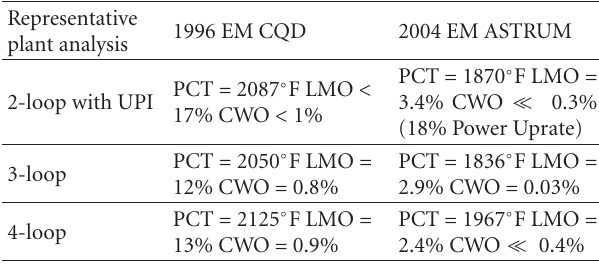
Table 2: Sample results of various BELOCA analyses. (Comparison between the 1996 EM and 2004 ASTRUM